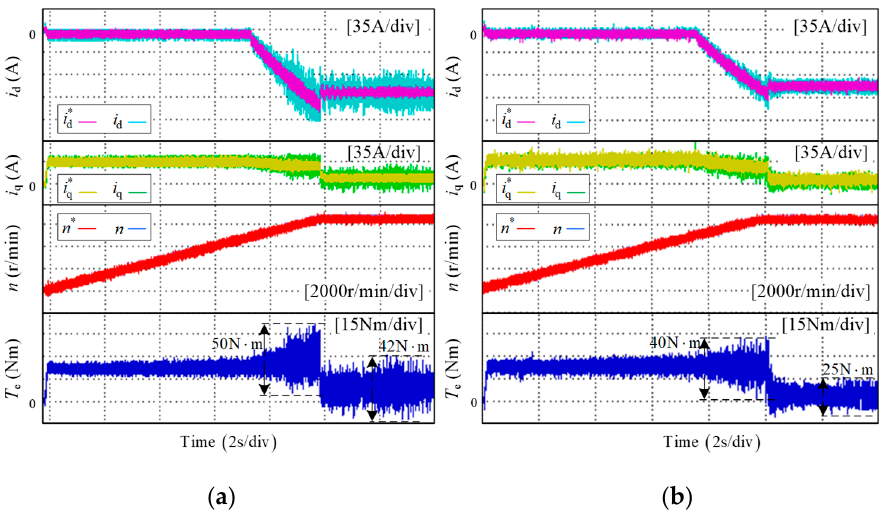
Figure 14. Experimental waveforms with L d0 = 1.2 L d , L q0 = 1.2 L q : ( a ) The traditional control strategy-based PI controller; ( b ) The improved UDE-based control strategy.